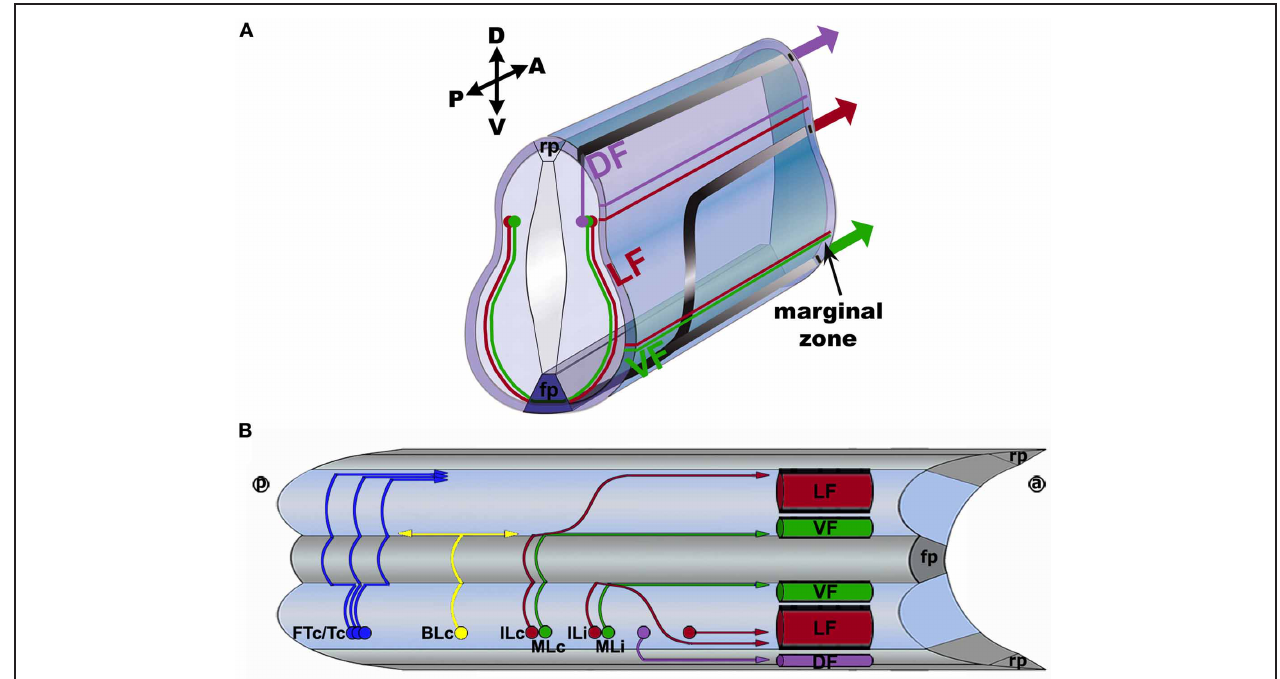
FIGURE 1 | Spinal axon trajectories within the vertebrate spinal cord. (A) Transverse view of the spinal cord shows ipsilaterally and contralaterally projecting axons growing within the spinal gray matter and, subsequently, the right side of the marginal zone. The axons of red neurons grow alongside the floor plate (fp), and project into the lateral funiculus (LF) of the spinal cord marginal zone, along either Intermediate Longitudinal commissural (ILc) or Intermediate Longitudinal ipsilateral (ILi) trajectories. The axons of green neurons extend adjacent to the fp along either Medial Longitudinal commissural (MLc) or Medial Longitudinal ipsilateral (MLi) trajectories to form the ventral funiculus (VF). The axons of purple neurons project ipsilaterally and dorsally to form the dorsal funiculus (DF) together with a subset of DRG axons (not shown). The cell body locations do not necessarily